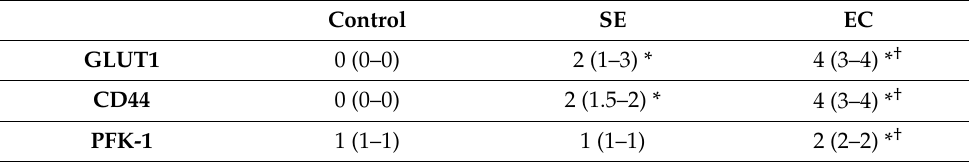
Table 1. Immunoreactivity of aerobic glycolysis markers in control and TGCTs.